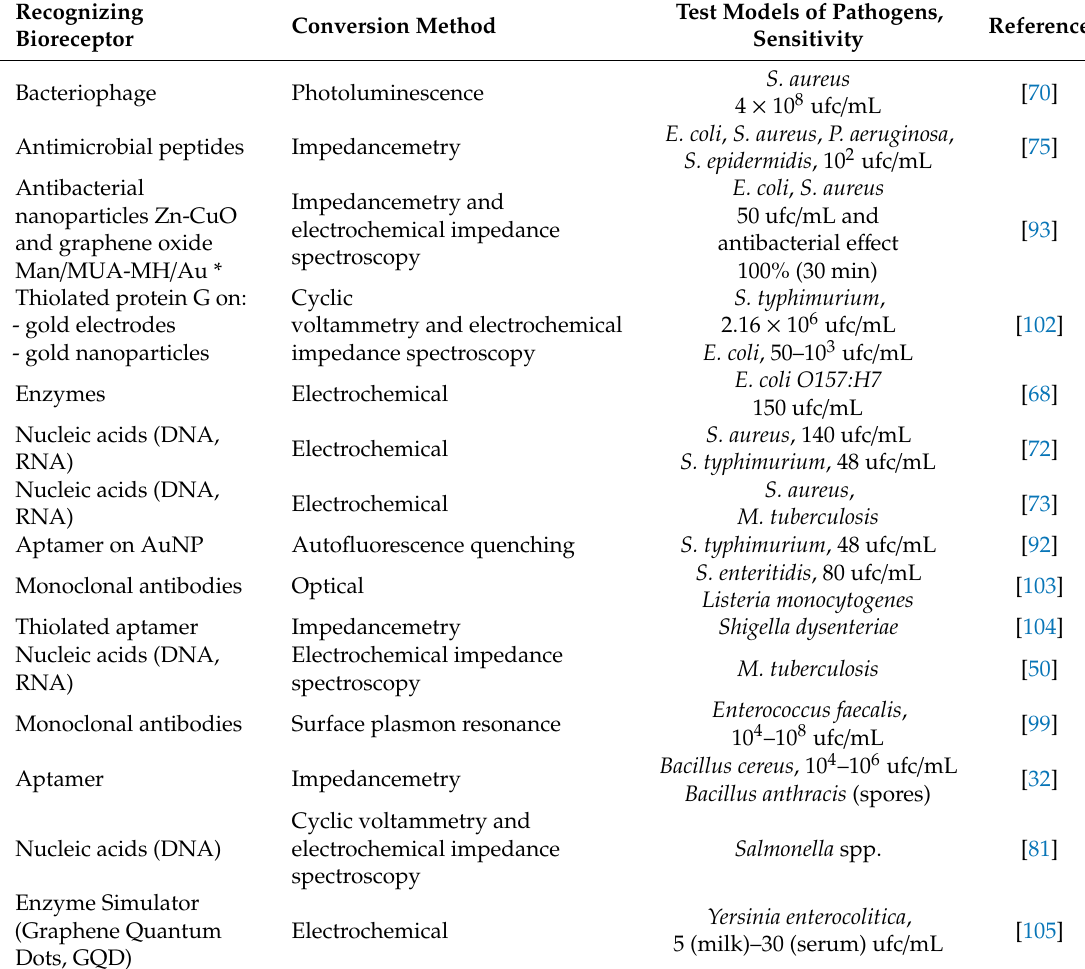
Table 3. Examples of modern designs of label-free biosensors for specific and non-specific indication of biological